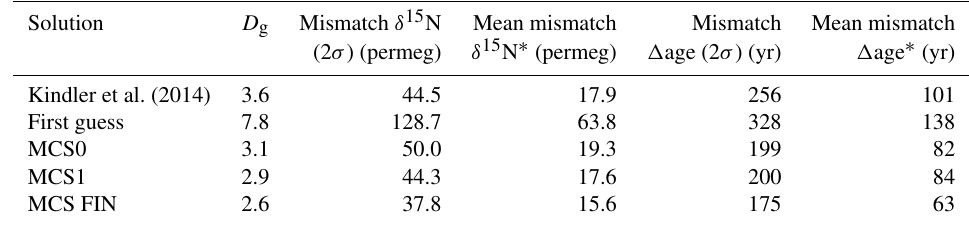
Table 6. Proof of concept for glacial reconstruction: D gl is the used minimization criterion (see Sect. 4.4). Solution D g Mismatch δ 15 N Mean